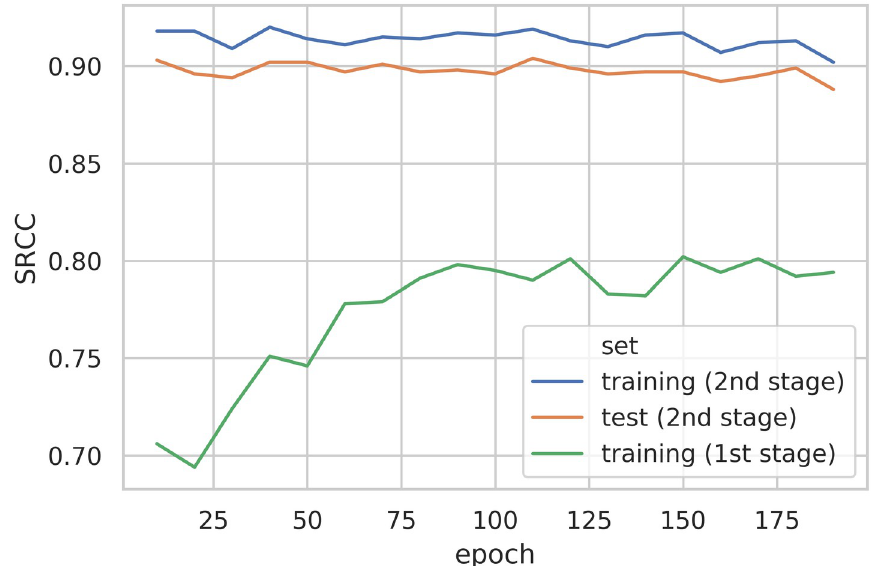
Fig 8. Performance (SROCC) of the DeepRN [7] model under data-leakage Case I. The network is trained in two stages. In the first stage the network is trained on the entire KonIQ-10k database for the number of epochs shown on the x-axis. Intermediate models are saved every ten epochs, and the second stage training is performed on each of them by correctly using the official training/validation and test sets. The first stage models are trained using the cross- entropy loss, outputting five class-likelihoods, one for each score range. In order to easily compare the reported performances of the two stages, we calculate the corresponding scalar scores from the class-likelihoods. The likelihoods form a distribution over the respective integer scores. Thus, we compute the SRCC between the means of these distributions and the corresponding ground-truth MOS. Neither the test, nor the training performance in the second stage matches the results reported in the DeepRN